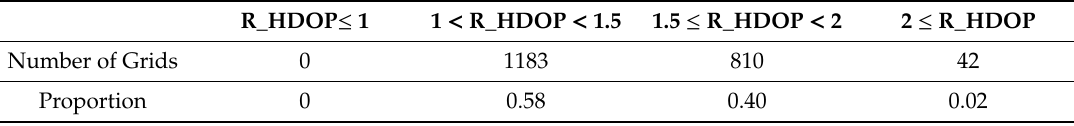
Table 9. Number of grids for the ratio of HDOP